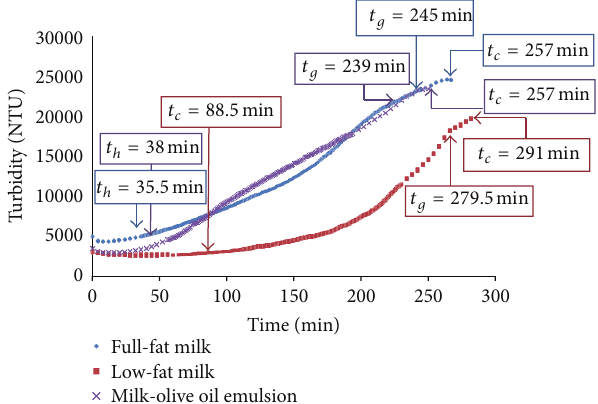
Figure 1: Turbidity evolution versus time of various renneted milk